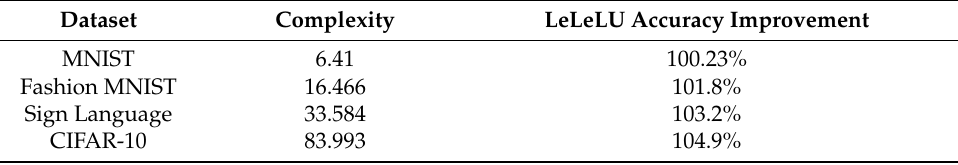
Table 8. Complexity of each dataset of Section 4.2, given the above algorithm and the corresponding LeLeLU accuracy